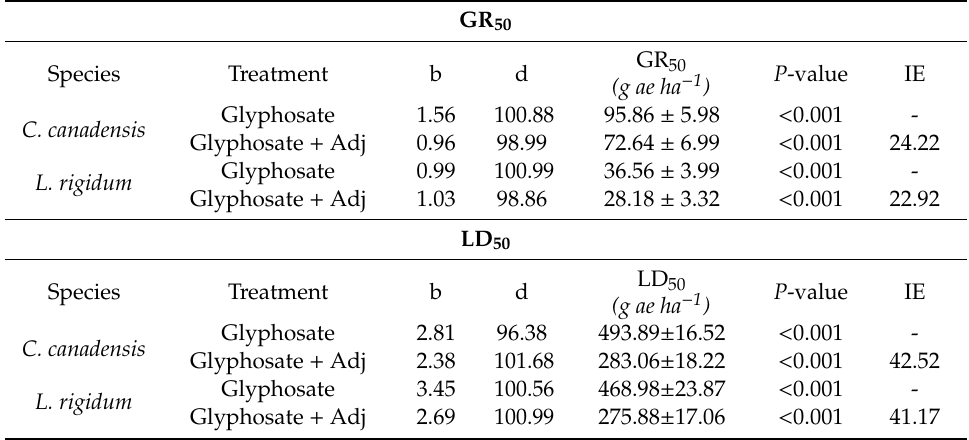
Table 1. Parameters of the log-logistic equations a used to calculate the glyphosate rates (g ae ha − 1 ) required for 50% reduction in dry weight (GR 50 ) or survival (LD 50 ) of C. canadensis and L. rigidum